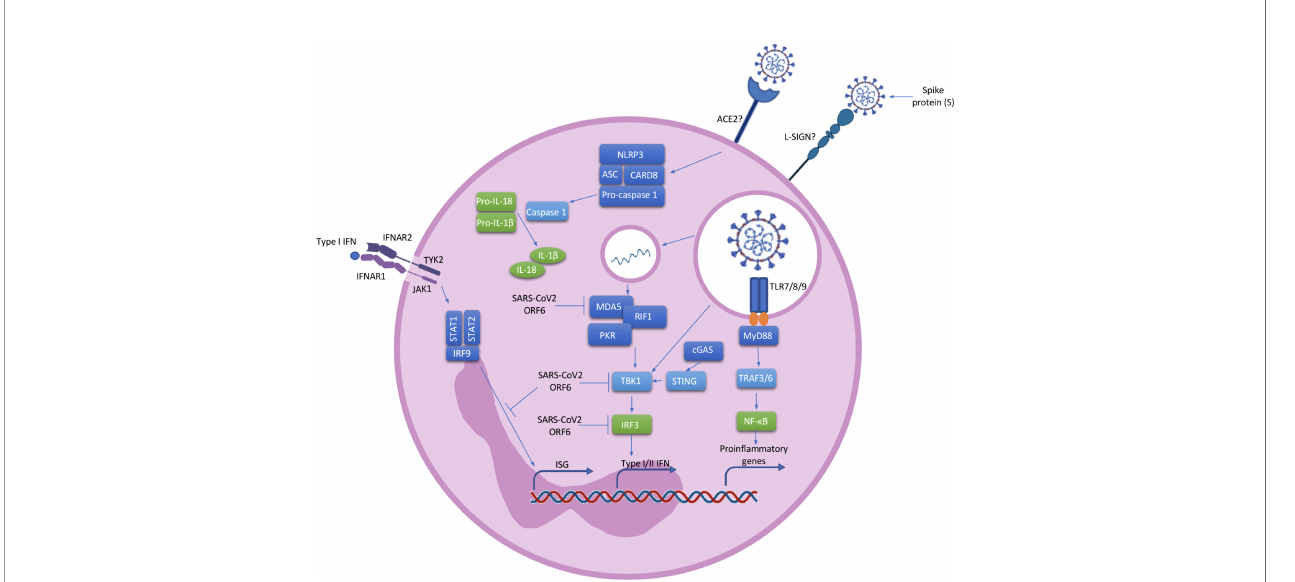
FIGURE 2 | Neutrophil activation. ACE2 or L-SING receptors on neutrophils most likely recognise SARS-CoV2 via a spike (S) protein on its surface. Once the virus enters the cell, ssRNA viruses such as SARS-CoV-2 are recognised by TLR 7/8/9 which induce the activation of the MyD88 pathway. MyD88 activates TRAF3 and TRAF6 which result in the transcription of NF- k B and IRF7 associated genes. The activated NF- k B pathway leads to the transcriptional induction of proin fl ammatory cytokines, chemokines and additional in fl ammatory mediators in neutrophils. In addition, cytosolic viral RNA recruiting MDA5, RIF1 and PKR lead to the activation of TBK1 and the further activation of IRF3 resulting in the transcription of type I/II IFN genes. The positive stimulatory loop by type I IFN induces the production of more IFNs through the JAK/STAT pathway and the induction of Interferon Stimulated Genes (ISG). At the same time, SARS-CoV-2 possess ORF6, an accessory protein antagonist of IFNs by the inhibition of MDA5, TBK1, IRF3 and IRF9. ssRNA viruses also cause the recruitment of the NLRP3 in fl ammasome complex and the further activation of pro-caspase-1 resulting in the cleavage of pro-IL- 1 b and pro-IL-18 into the active forms. ACE2, angiotensin-Converting Enzyme 2; L-SING, L-Speci fi c Intercellular adhesion molecule-3-Grabbing Non-integrin/CD209L; RNA, ribonucleic acid; ssRNA, Single-stranded RNA; TLR, toll-like receptor; MyD88, myeloid differentiation primary response 88; TRAF, tumor necrosis factor receptor (TNF-R)- associated factor; NF- k B, nuclear factor kappa B; IRF, Interferon Regulatory Factor; MDA, melanoma differentiation-associated protein; RIF, Replication Timing Regulatory Factor; PKR, protein kinase R; TBK, TANK Binding Kinase; IFN, interferon; ISG, Interferon Stimulated Genes; JAK-STAT, janus kinase; ORF, open Reading Frame; NLRP3, nod like receptor family, pyrin domain containing 3; IL,